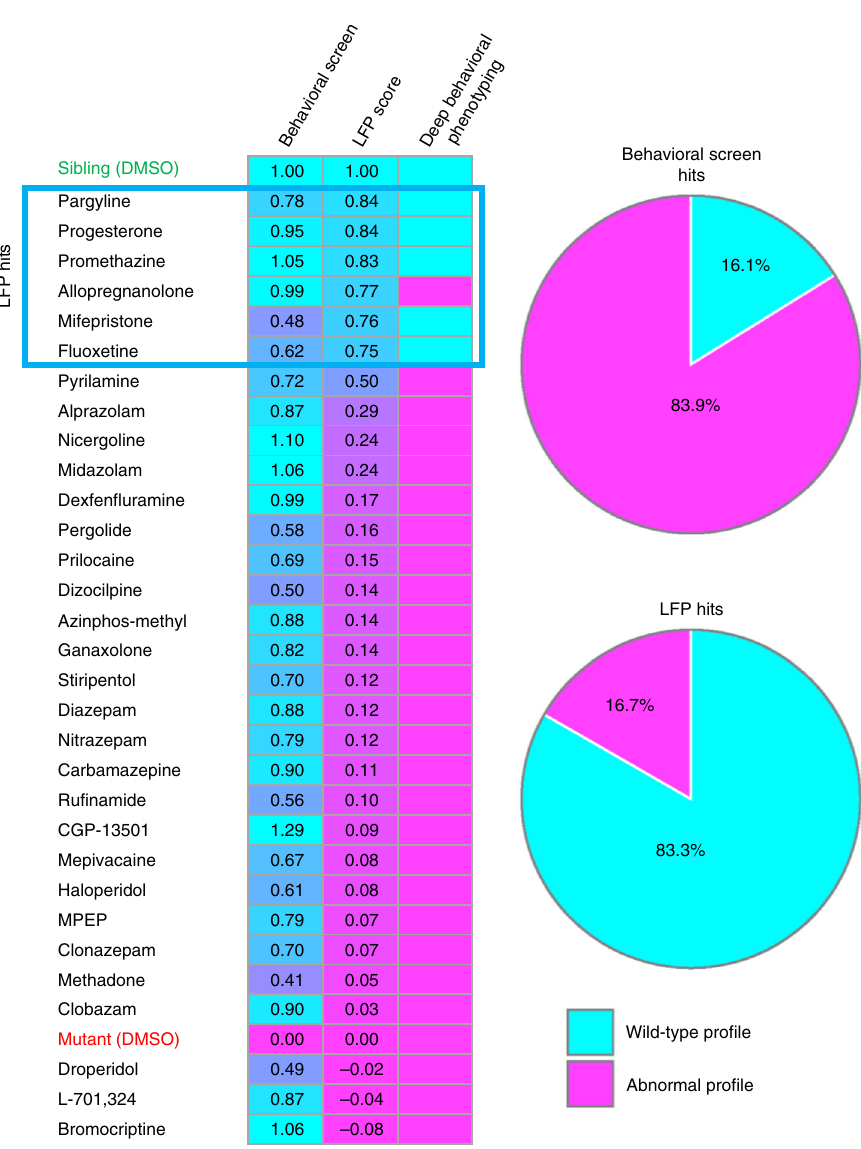
Fig. 5 Brain activity pattern screening substantially reduces the false-positive rate. (Left) All compounds are ranked based on composite LFP scores. Compounds with a wild-type activity pro fi le based on deep behavioral phenotyping (right column) are indicated in cyan; those with an abnormal pro fi le are indicated in magenta. Top hits based on composite LFP scores are indicated in the blue box. (Right) Classi fi cation based on deep behavioral phenotyping ( n = 10+ larvae, each subjected to four independent light stimuli) of all hits from the preliminary (single-metric) behavioral screen ( n = 8+ larvae, each subjected to four independent light stimuli) and the LFP-complexity screen ( n = 5 – 11 per compound). 26 out of 31 hits (83.9%) identi fi ed in the preliminary behavioral screen exhibit signi fi cant behavioral abnormalities when evaluated in detail. In contrast, only 1 out of 6 hits (16.7%) based on the composite